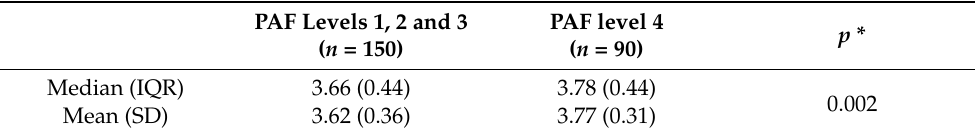
Table 3. Health-related quality of life and physical activity frequency comparison in Spanish children and adolescents with asthma.